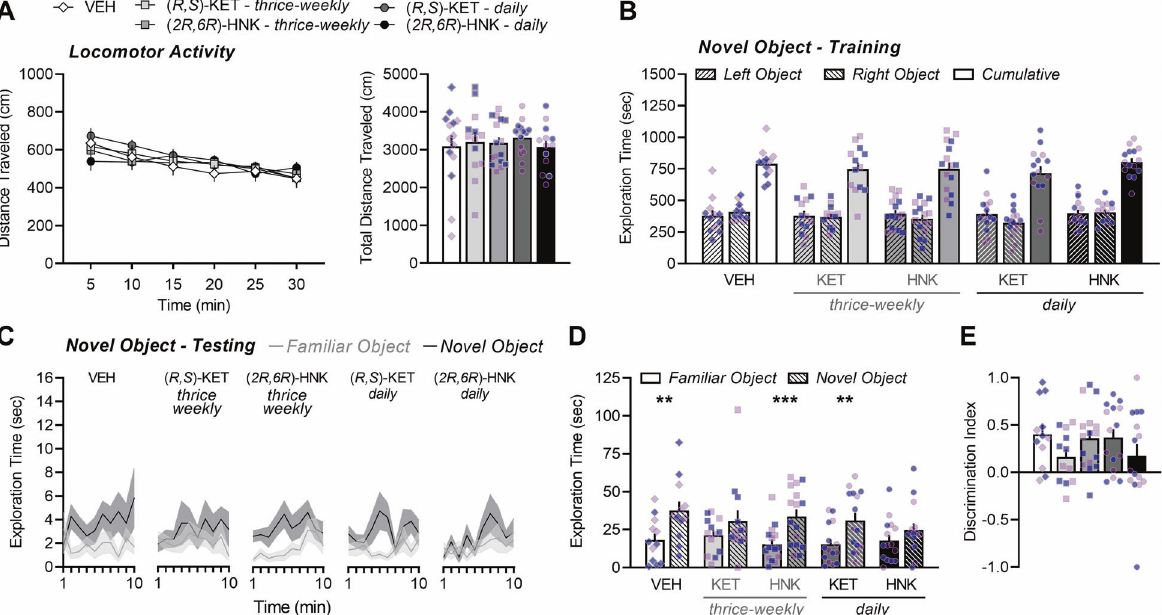
Fig. 4 Adults treated with thrice-weekly ( R,S )-ketamine or daily ( 2R,6R )-hydroxynorketamine have impaired novel object recognition later in adulthood. A Locomotor activity during the habituation phase of the novel object-recognition task (i.e., in the absence of objects) plotted as 5-min time bins (left) and summarized as total distance traveled over the total 30 min (right). B Total time spent exploring two identical objects during the 30 min of training. C Time spent exploring the familiar object and the novel object across the 10 min of testing. D Total time spent exploring the familiar object and the novel object during the 10 min of testing and ( E ) plotted as a discrimination index (right): (novel-familiar)/(novel + familiar). Data are presented as mean ± standard error of the mean. ** P < 0.01, *** P < 0.001.